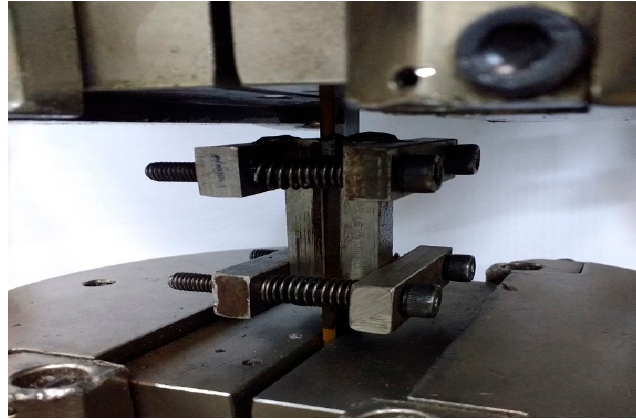
Figure 6. Clamped specimen with fixture.